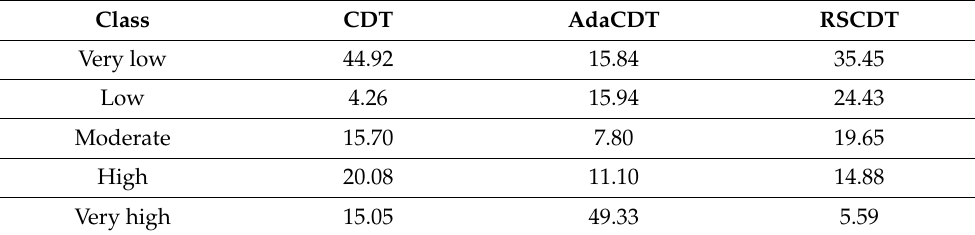
Table 4. Percentages of different landslide susceptibility classes for CDT, AdaCDT, and RSCDT models.